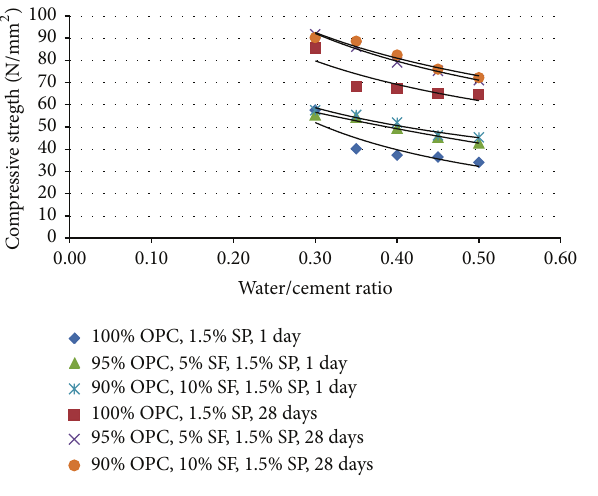
Figure 3: Influence of water/cement ratio on compressive strength at 1 day and 28 days.